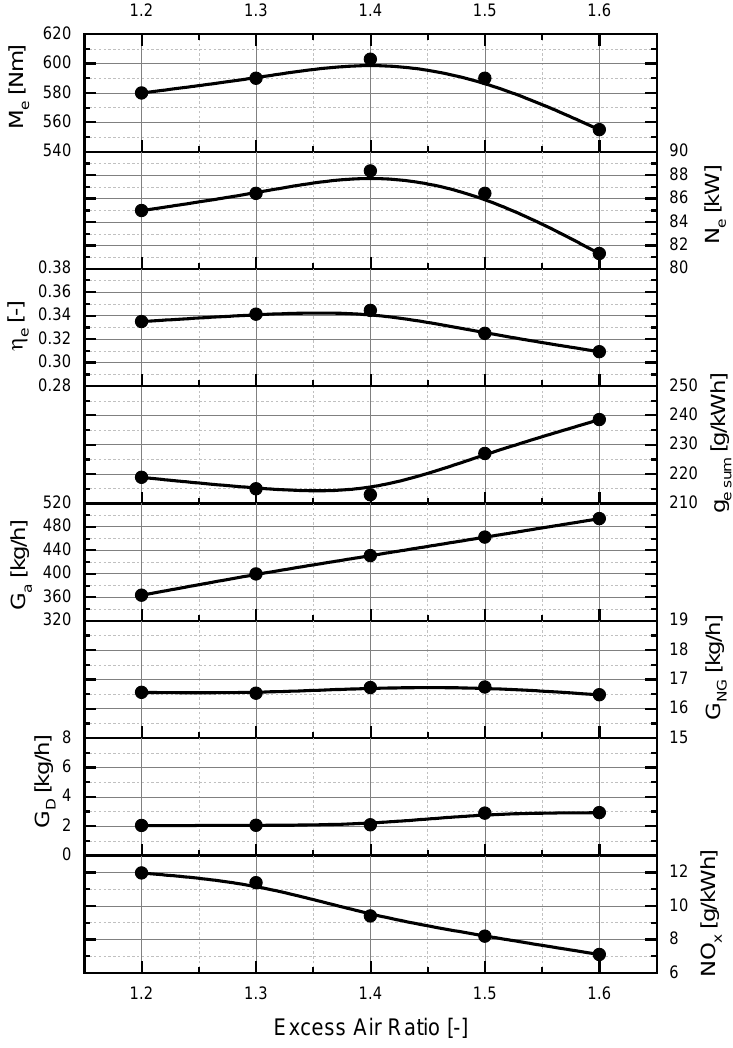
Figure 11. Engine parameters versus excess air ratio (n = 1400 rpm).